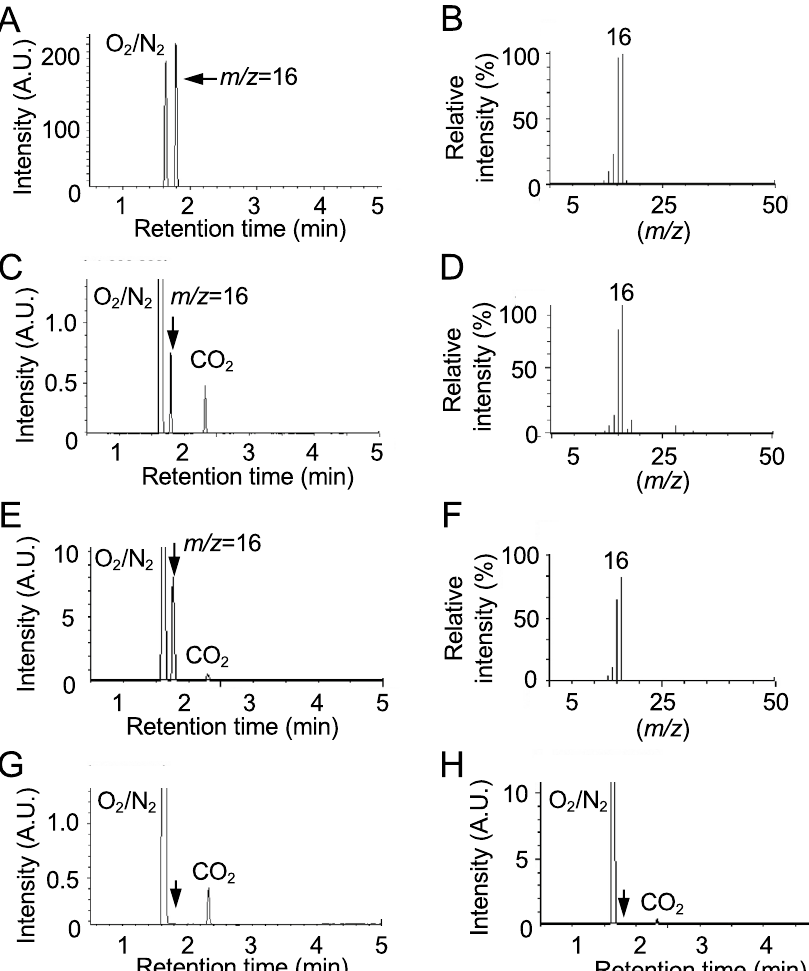
Figure 4. Detection of CH 4 during dimethylmercury or methylmercury incubation by GC/MS analysis . The arrows indicate CH 4 . ( A ) Chromatogram of authentic CH 4 and ( B ) spectrum of the peak with a retention time of 1.79 min. Compounds in the head space of DMeHg solution after ( C , D ) 3 h or ( E , F ) 4 days of incubation were analyzed by GC/MS. ( C , E ) Chromatogram of the collected compounds and ( D , F ) spectrum of the peak with retention time of 1.79 min. Chromatogram of the collected compounds in the head space of MeHg solution after ( G ) 3 h or ( H ) 4 days of